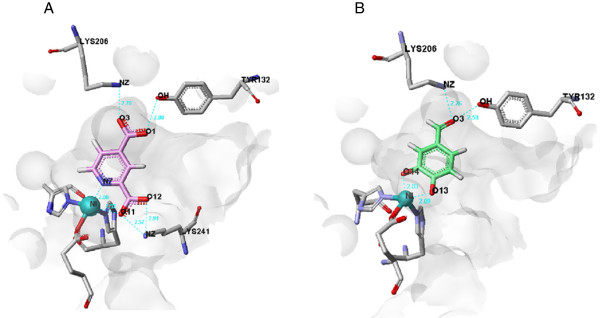
View of the conformation of PA docked in the JMJD2A active site. (A) Binding mode of 2,4-PDCA in JMJD2A. (B) Binding mode of PA in JMJD2A.